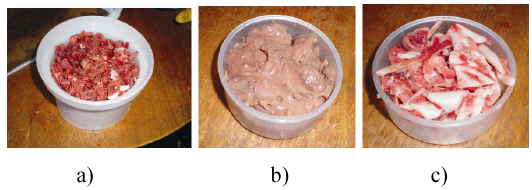
Fig. 2. Samples of fox organs and tissues ready for analysis: a – muscle, b – liver, c – bones Test-samples of fox organs and tissues chopped up prior burning. Then test-samples mineralized using SNOL-1,6.2,5.1/9-I5 moisture oven until a white ash was obtained. Prepared test-samples put into Marinelli ves- sels for further analysis. Sampling of plants and mouse-like rodents per- formed during summer season in Garbenas forest ( Uk- mergė district) and its surroundings. 4 bank (common red-backed) voles ( Clethrionomys glareolus ) and 9 striped field mice ( Apodemus agrarius ) captured. (10 pcs., every 15 m). One of the trap-lines set in the forest ant the other – in the field two kilometers away. An oil fried bread used as bait. Traps kept in place for 48 hours and checked once a